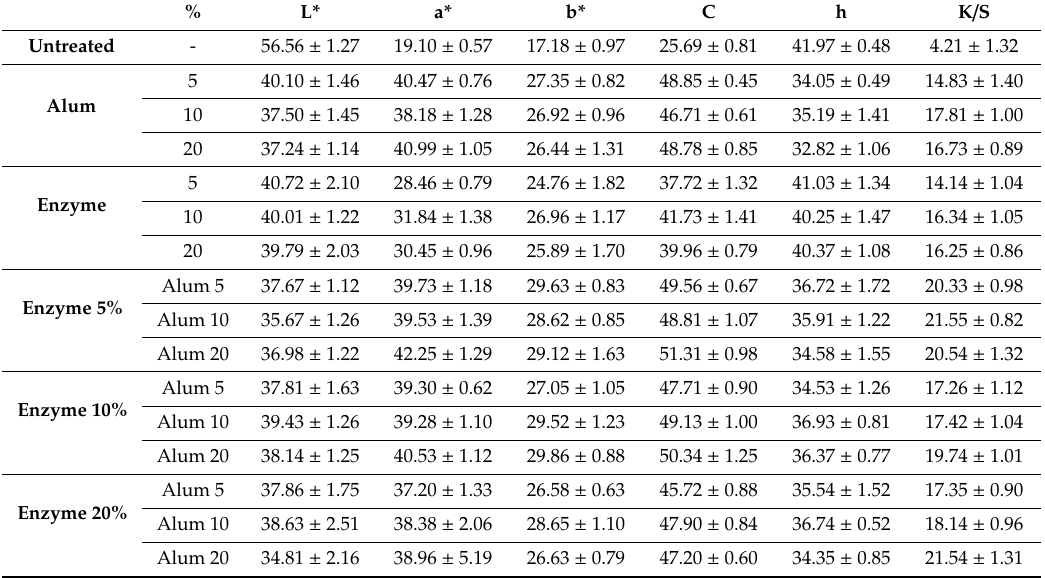
Table 1. Colorimetric properties of wool fibers dyed with madder treated with alum and m-TGase at different conditions .